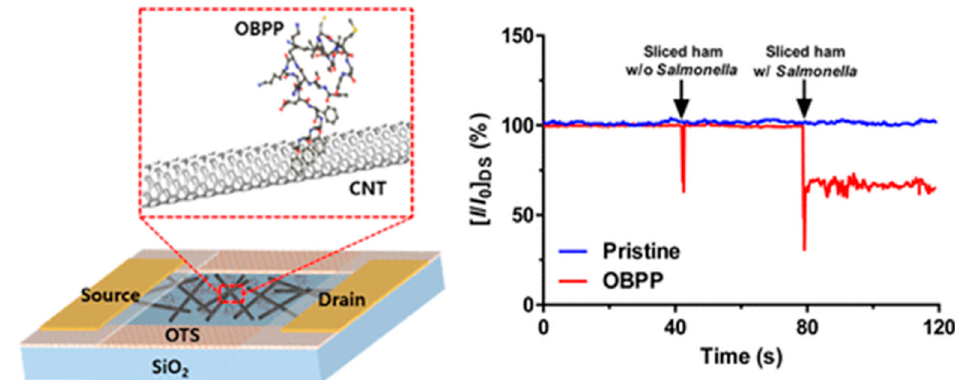
Figure 18. Schematic setup of CNT-FET for the detection of Salmonella contamination in ham and real-time detection of Salmonella contamination in sliced ham [165]. Copyright 2016, American Chemical Society.